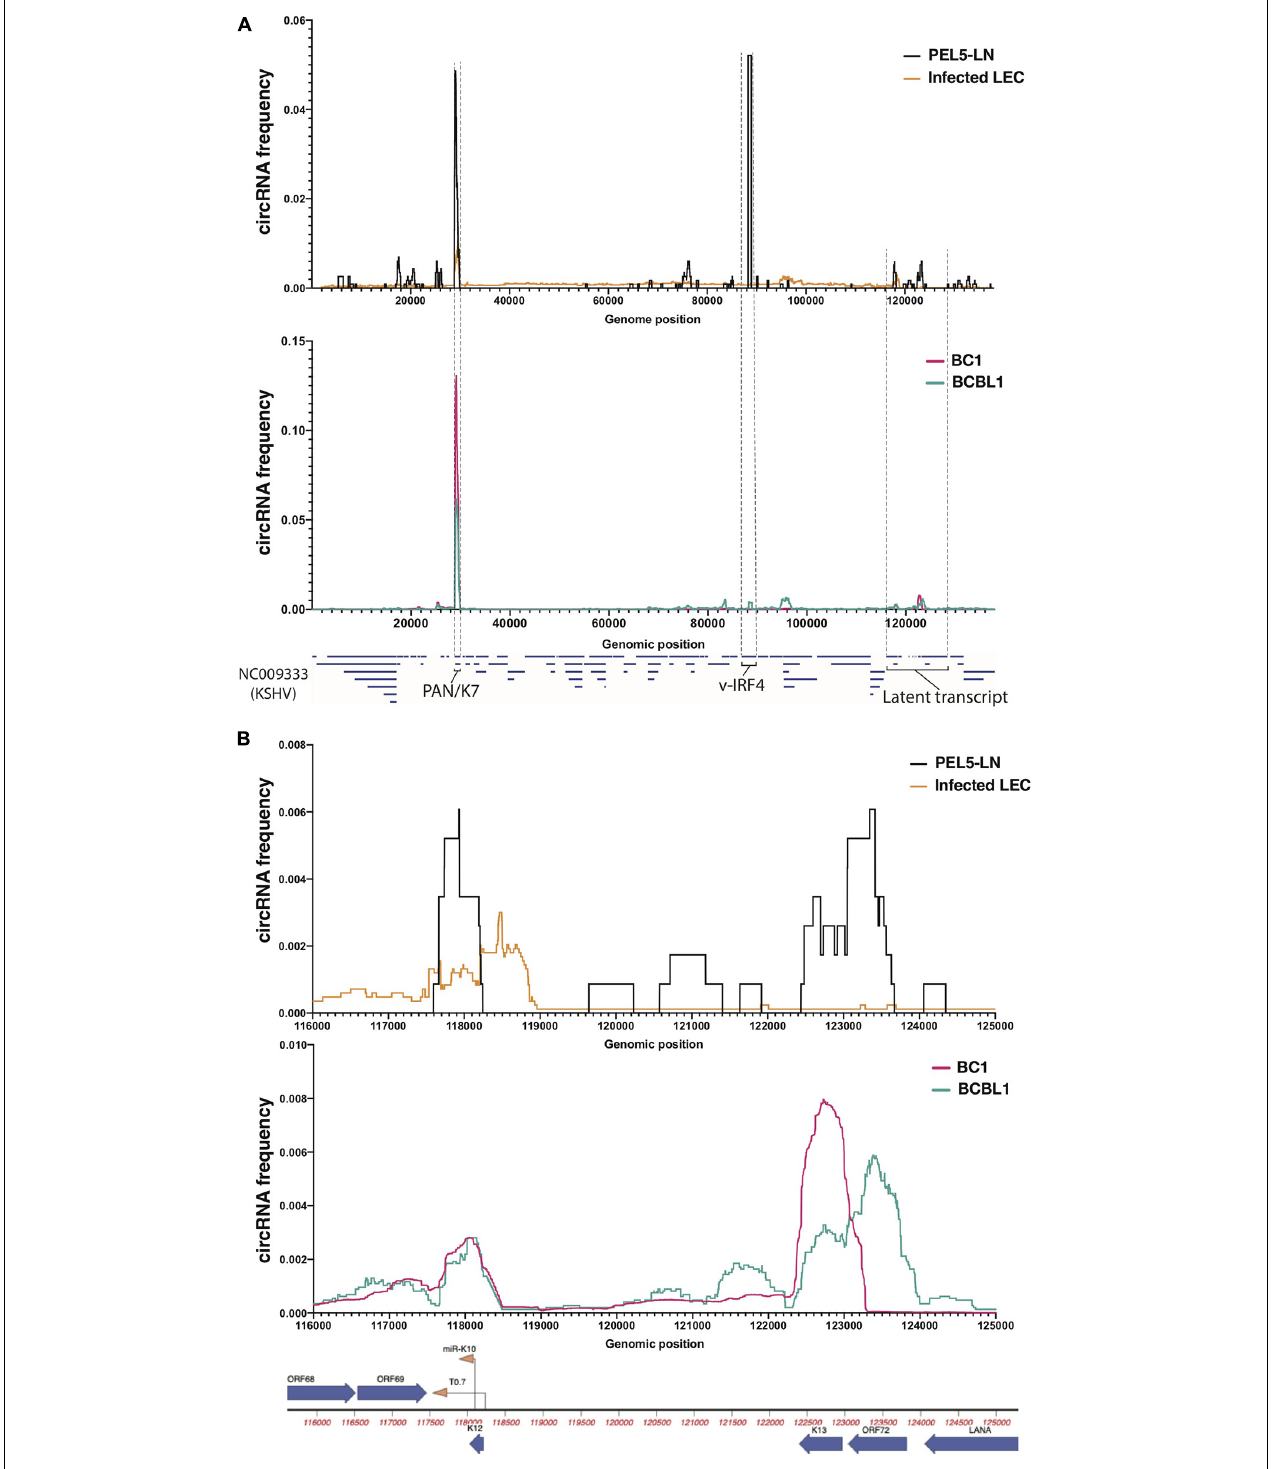
FIGURE 1 | Profiles of KSHV circular RNAs detected by RNA-Seq. Frequency histograms of KSHV circular RNAs in a lymph node of KSHV-positive patient (PEL5-LN) compared with de novo infected LECs (above), and reactivated KSHV-positive B cell lines (below). Detected viral circular RNA frequencies based on back-splice junctions (BSJ) reads (see section “Materials and Methods” for detail) from circRNA-Seq (PEL5-LN and B cell lines) or Ribosomal RNA-depleted RNA-Seq (LECs) are shown as percentages of total detected viral BSJ reads (y-axis) across the whole KSHV genome (A) or the KSHV latent transcript region (B)